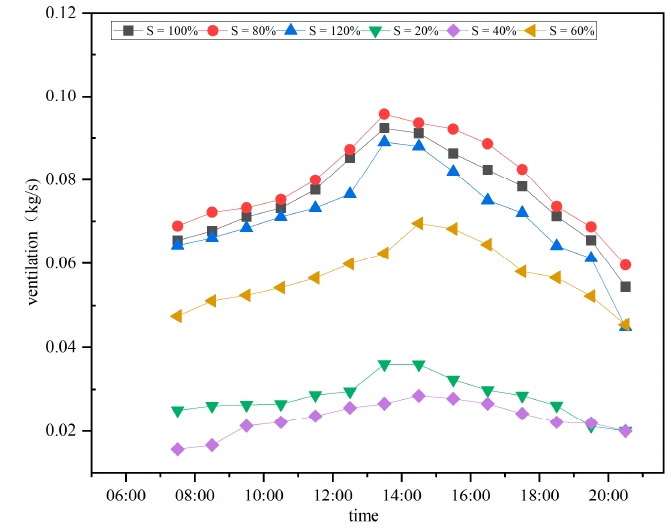
Figure 11. Air mass flow rates of wall-mounted solar chimneys at different times.